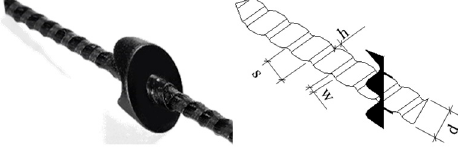
Figure 2. Typical BFRP connector.